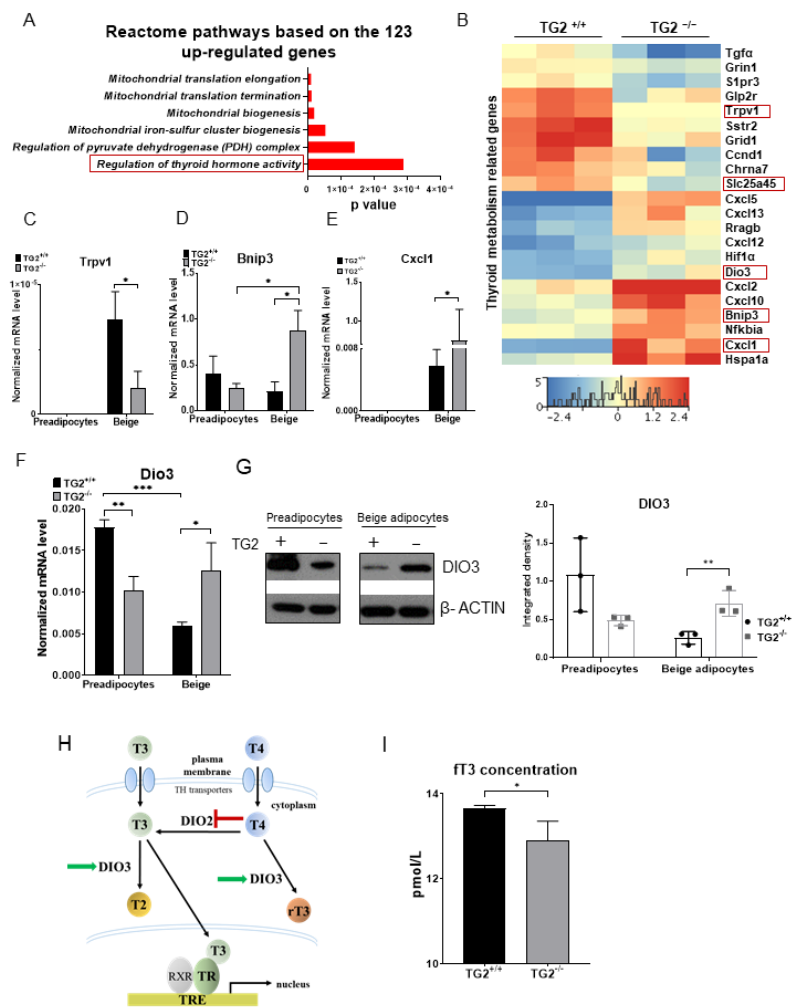
Figure 6. Upregulated mitochondrion-related genes in TG2 −/− beige cells as compared with TG2 +/+ : ( A ) Upregulated reactome pathways in the TG2 −/− beige samples, based on the gene ontology (GO, Reactome pathway) analysis; ( B ) heatmap of the thyroid metabolism-related genes in beige adipocytes, framed genes were selected for validation; ( C – F ) validation of the selected thyroid metabolism-related genes using RT-qPCR analyses; ( G ) representative Western blot analysis and quantitative analyses of DIO3 in preadipocytes and differentiated beige cells, β -ACTIN was used as loading control; ( H ) schematic representation of DIO3 in thyroid hormone inactivation, the panel is a modification of a figure from [40]; ( I ) fT3 concentration in the differentiation medium of the beige cells. Columns represent the mean values ± SD. Statistical analyses were performed using Student’s t-test. n = 3. * p < 0.05, ** p < 0.01, *** p < 0.001. 2.7. Expression of Transporters of Acylcarnitine, CoA, and Certain Amino Acids into the Mitochondria Is Lower in TG2 −/− Cells as Compared with the TG2 +/+ Controls The gene ontology analysis showed that the downregulated genes in the TG2 −/− beige samples were significantly enriched for the metabolism and transport of amino acids and derivatives (Figure 7A). Some upregulated solute carriers ( Slc s) genes could perform the